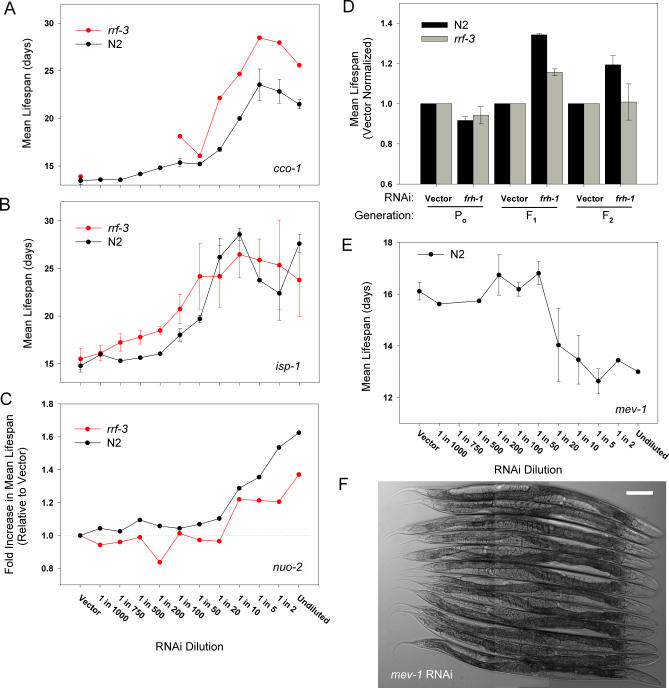
A Threshold Effect Differentially Modulates Adult Lifespan in cco-1, isp-1, nuo-2, frh-1, and mev-1 Mitochondrial Mutants(A, B, and C) RNAi dilution series for cco-1 (A), isp-1 (B), and nuo-2 (C) were established using N2 (black lines). Adult lifespan increases significantly (p < 0.05) for cco-1, isp-1, and nuo-2 at RNAi dilutions of 1:200, 1:50, and 1:20, respectively. Lifespan noticeably peaks for cco-1 and isp-1 at dilutions of 1:10 and 1:5, respectively. The RNAi-enhancing rrf-3(pk1426) mutation (red lines) caused almost no alteration in the threshold for life extension within each RNAi dilution series. (Data are the average of at least two independent experiments ± SEM).(D) Wild-type (N2) and rrf-3(pk1426) mutant animals were cultured for three consecutive generations on bacteria expressing frh-1 or control (vector) RNAi. Lifespan analysis of synchronous parental (Po), and filial (F1 and F2) populations was undertaken in duplicate for each condition (n = 60 worms/condition). Data for each strain, at each generation, are normalized relative to the respective vector condition.(E) A mev-1 RNAi dilution series was established using N2 animals (n = 60 worms/condition). A significant life-shortening effect beginning at a dilution of 1:20 is apparent (p = 6.6 × 10−13).(F) Nomarski images of randomly selected 1-d-old animals from a mev-1 RNAi dilution series (400×): top to bottom (target gene to empty vector ratio), 0:1, 1:1,000, 1:750, 1:500, 1:200, 1:100, 1:50, 1:20, 1:10, 1:5, 1:2, and 1:0. No size reduction at any dilution is evident) Scale bar indicates 100 μm.